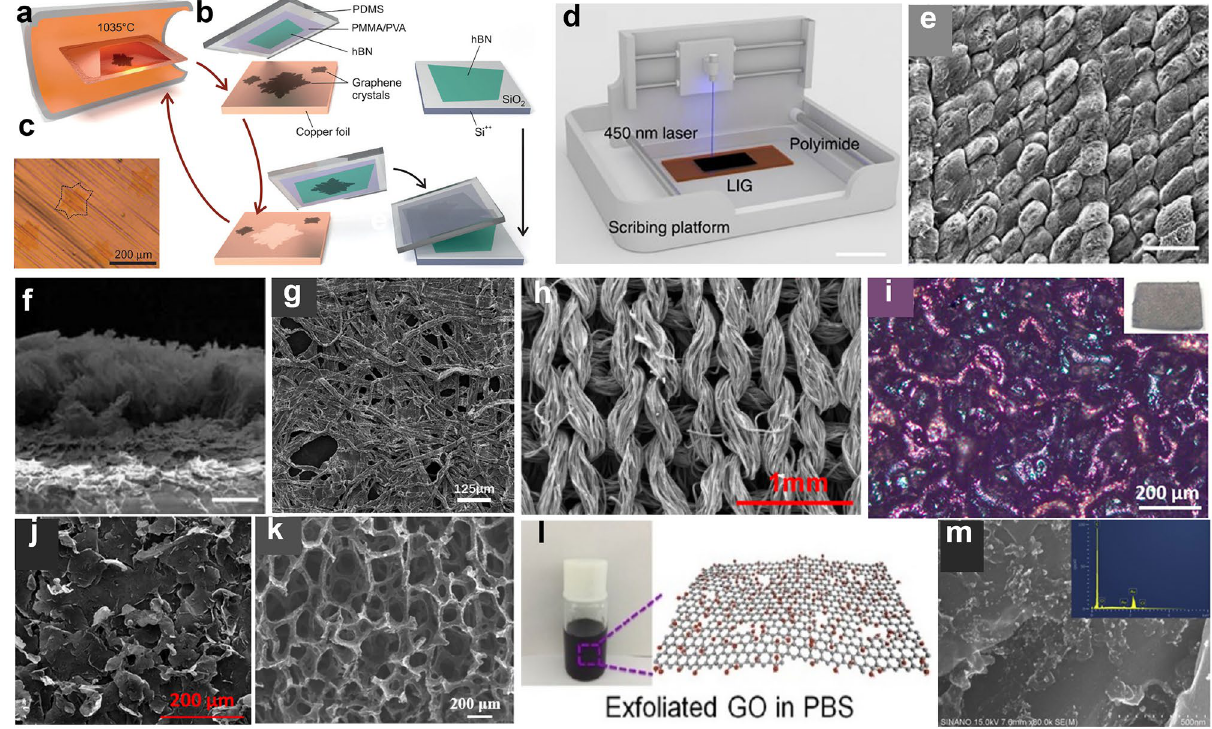
Fig. 3 Microstructure and fabrication process of graphene-based devices. a Illustration of the CVD furnace with a Cu enclosure inside. b Pro- cess schematic of the contamination-free transfer of CVD graphene from Cu onto hBN. c Optical microscopy image of grown graphene crystals on Cu foil. Reproduced with permission [69]. Copyright (2015), American Association for the Advancement of Science. d Schematic illustration of the fabrication process of LSG, and e the morphology of LIG sample produced at 290 mW under SEM. Scale bar represents 150 μm. f Cross- sectional view of LIG sample produced at 290 mW. Scale bar represents 12.5 μm. Reproduced with permission [101]. Copyright (2017), Nature Publishing Group. g SEM images of the tissue paper with rGO. Reproduced with permission [102]. Copyright (2017), American Chemical Society. h SEM image of the graphene textile. Reproduced with permission [103]. Copyright (2018), American Chemical Society. i Bioinspired graphene pressure sensor with a random distribution spinosum microstructure. Reproduced with permission [104]. Copyright (2018), Ameri- can Chemical Society. j Self-overlapping graphene sheets and stacked structure with numerous interlayer gaps. Reproduced with permission [105]. Copyright (2018), American Chemical Society. k SEM images of porous graphene network. Reproduced with permission [21]. Copyright (2018), Elsevier. l Schematic illustration of the GO in PBS, and m Typical SEM images of rGO/Au nanoparticles (AuNPs) composite (Insert is the corresponding Energy dispersive X-ray spectrometry (EDS)) which can be used for electrocatalytic oxidation of nitrite at the electrode